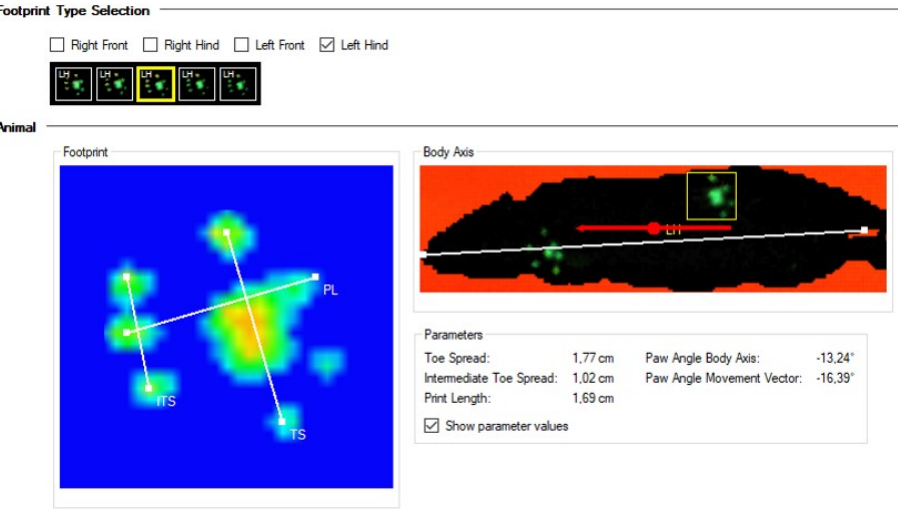
Figure 3. Individual paw evaluation in a Wistar rat registered using CW system at normal passing speed. Upper panel depicts the indicated paw print. Lower panel depicts graphical and numerical registration of the parameters (toe spread, intermediate toe spread, print length, paw angle body axis (paw angle versus body angle), and paw angle movement vector).